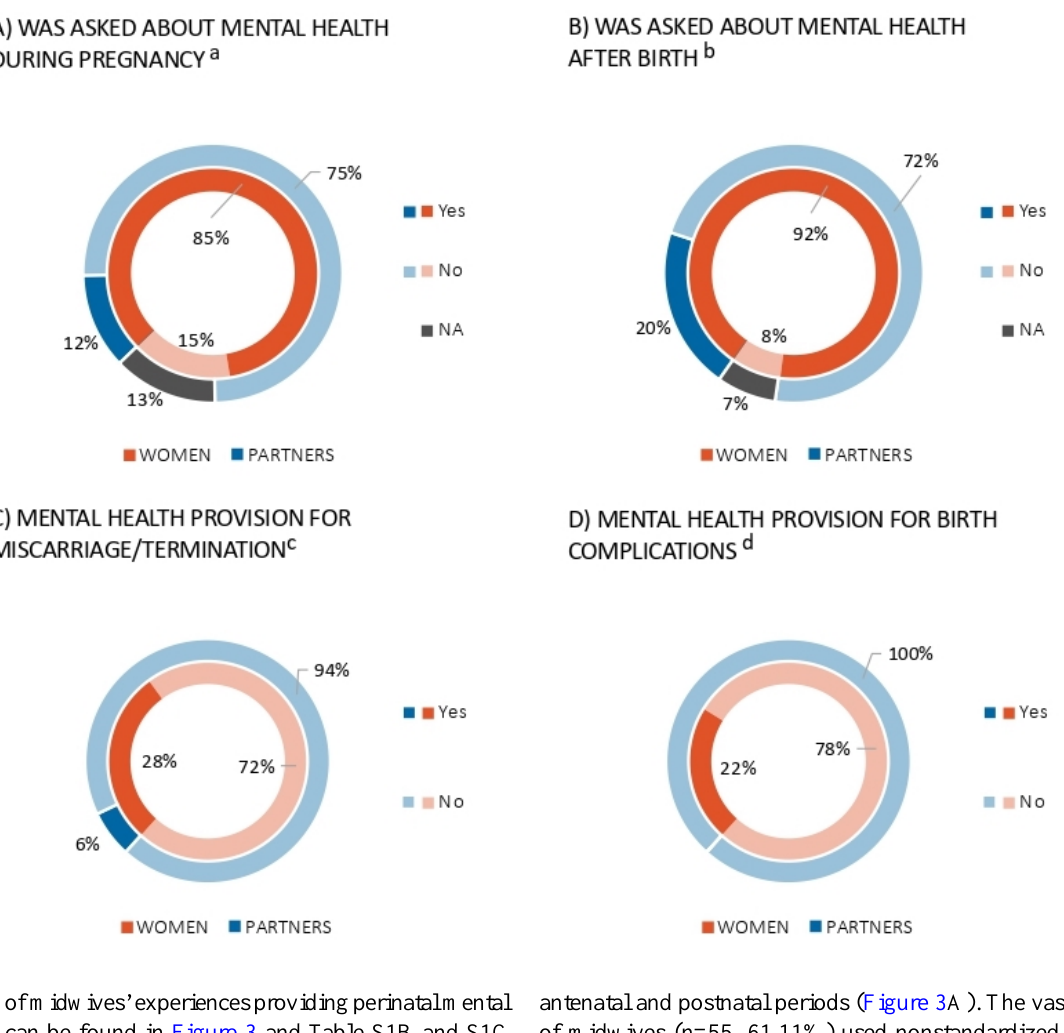
Figure 2. Perinatal mental health provision for women and partners, including being asked about their mental health during pregnancy (A) and after giving birth (B), as well as being offered mental health support following a miscarriage or termination (C) and after a difficult birth (D). a: Includes those who are pregnant or have given birth (women: n=753; partners: n=92); b: Includes those who have given birth (women: n=494; partners: